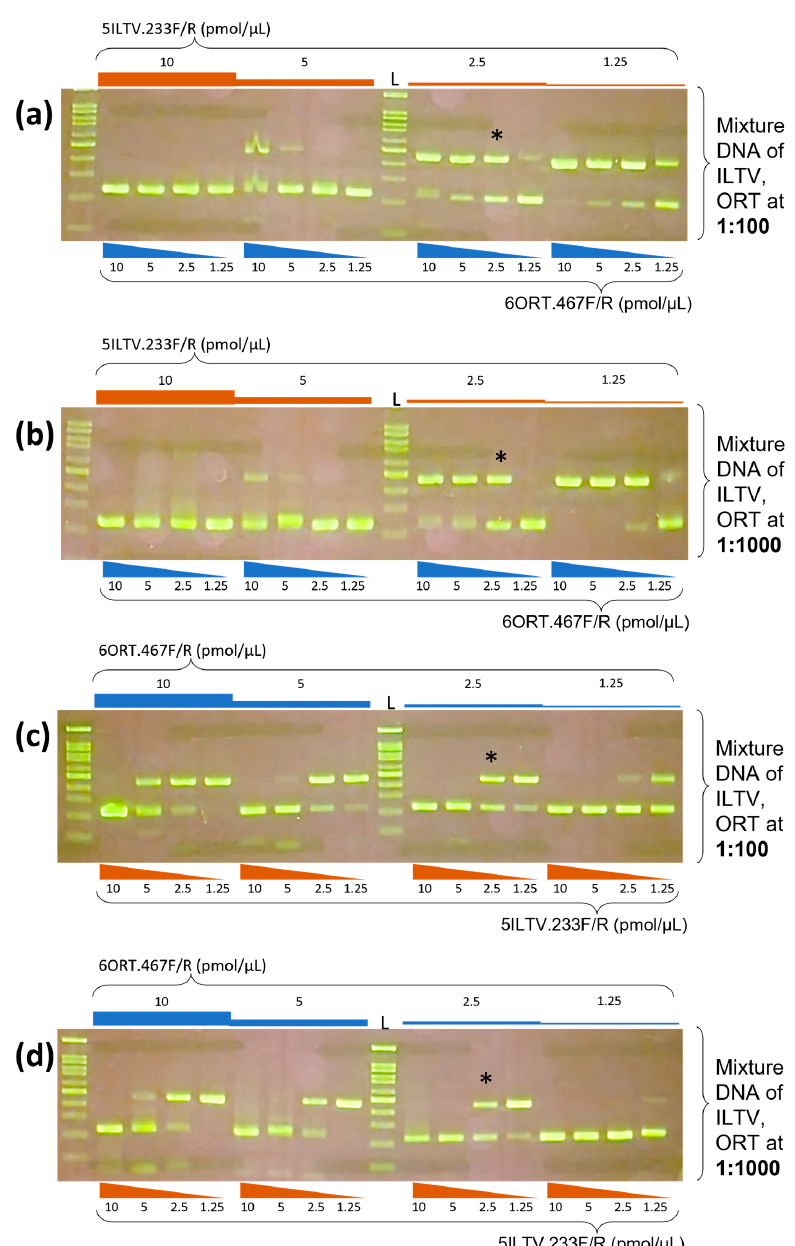
Figure 2. Optimization of primer concentration. In total, 16 combinations of different concentration of specific primers for ILTV and ORT were evaluated. The range of initial concentration for each primer set was from 10 to 1.25 pmol/µL. ( a , b ) Results of multiplex PCR with variable concentration of 6ORT.467F/R at each fixed concentration of 5ILTV.233F/R. ( c , d ) Results of multiplex PCR with variable concentration of 5ILTV.233F/R at each fi xed concentration of 6ORT.467F/R. The multiplex PCR reactions were performed at optimal annealing temperature and with two dilutions of mixture template DNA: 100 bp DNA ladder (L); the lowest band was 100 bp. * indicates the optimal concen- tration.